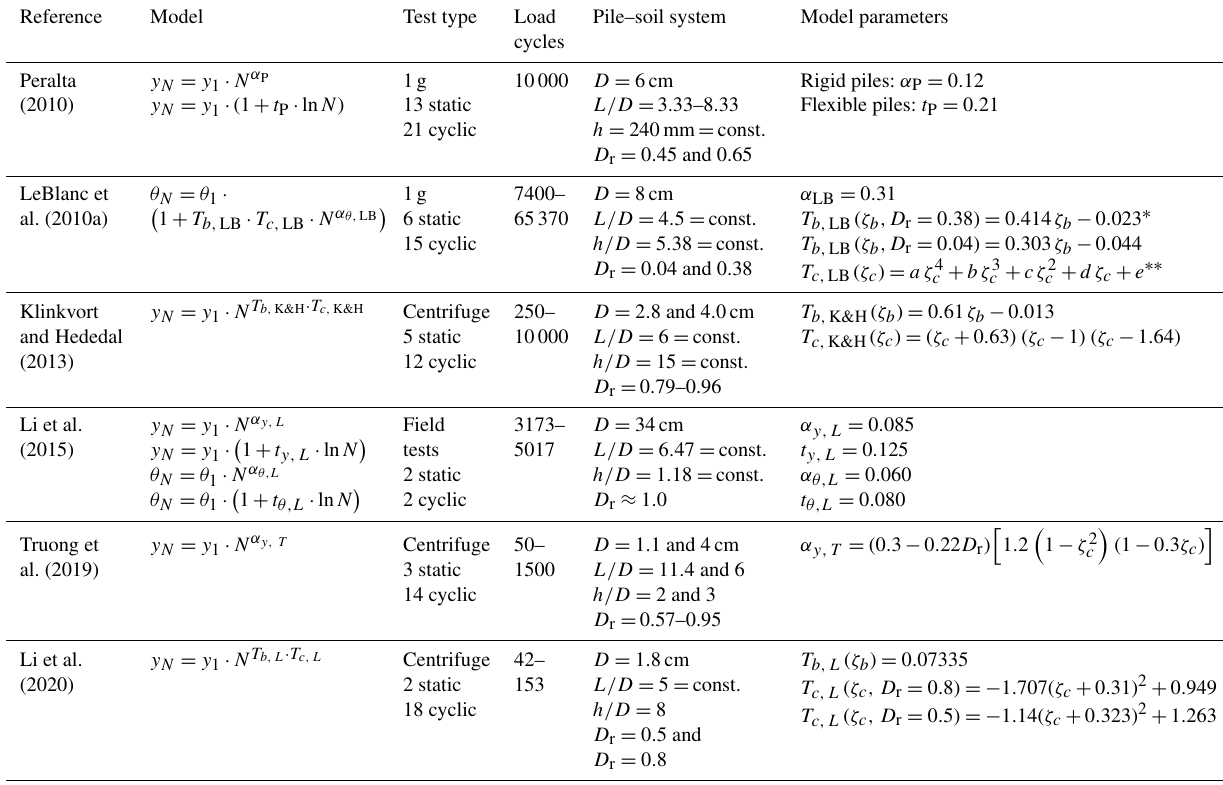
Table 1. Overview of models for cyclic displacement or rotation accumulation resulting from lateral cyclic loading. Reference